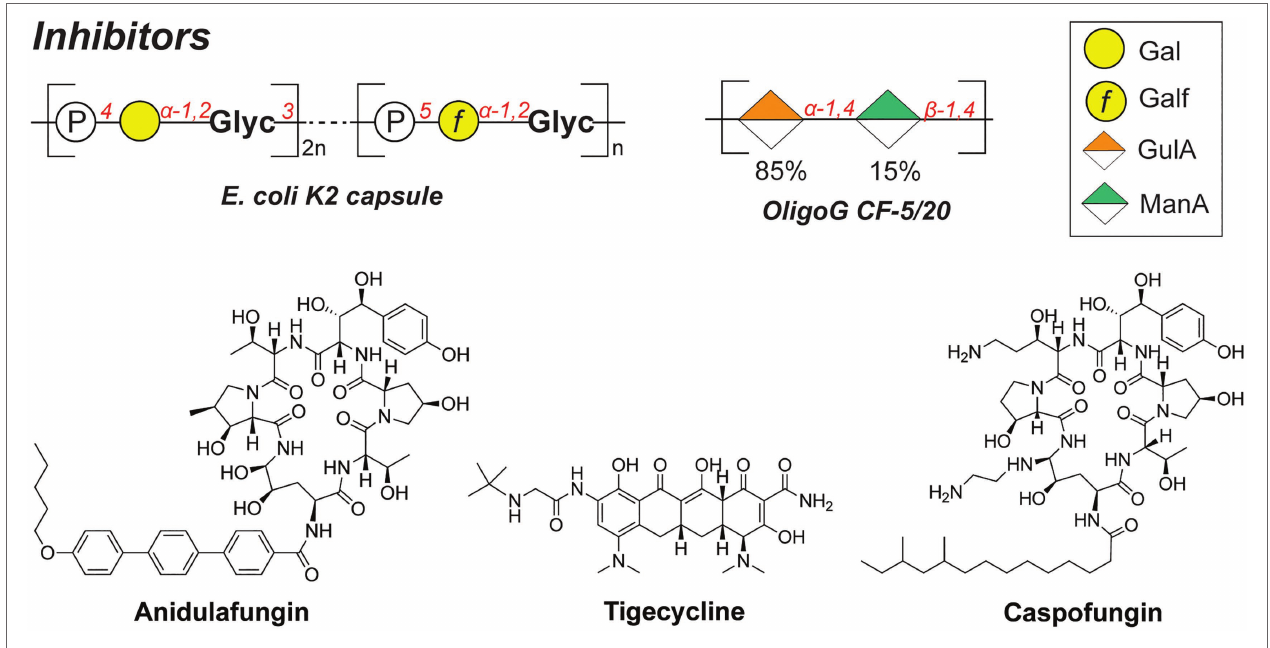
FIGURE 6 | Structures of biofilm inhibitors described in this